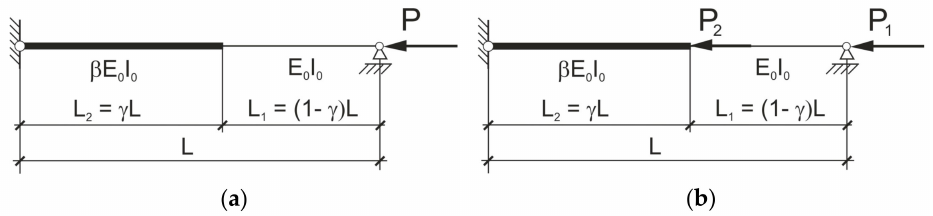
Figure 2. Columns of stepwise variable bending stiffness loaded: ( a ) By force P applied at the end; ( b ) By forces P 1 and P 2